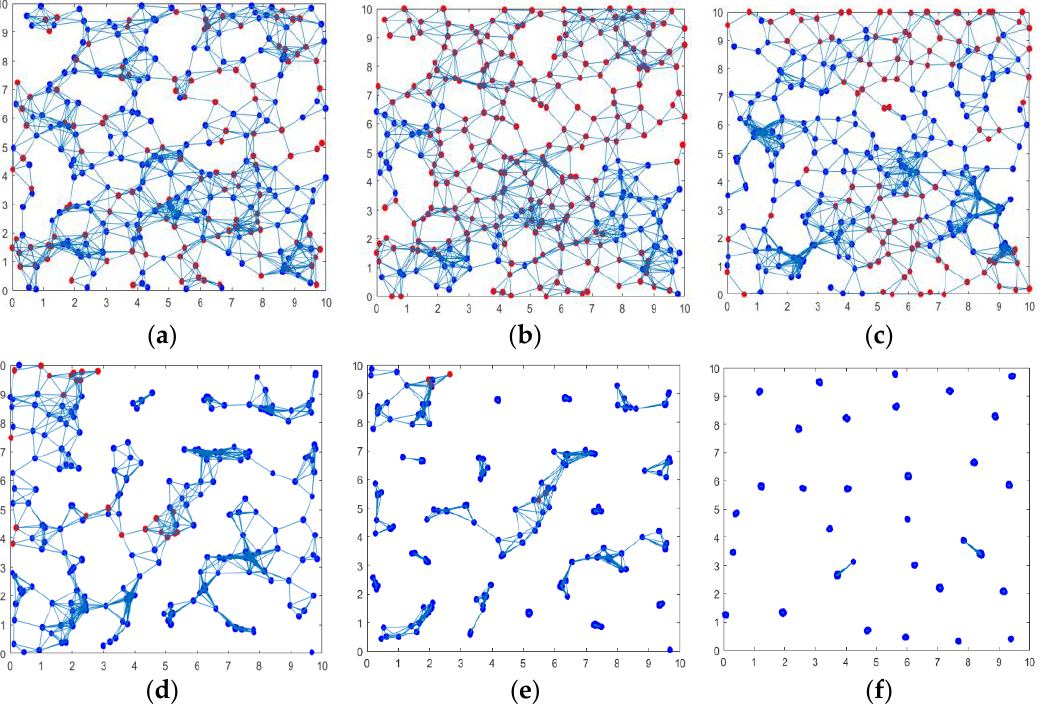
Figure 7. Evolutionary process of cooperator model. ( a ) t = 0; ( b ) t = 20; ( c ) t = 60; ( d ) t = 100; ( e ) t = 150; ( f ) t = 200.